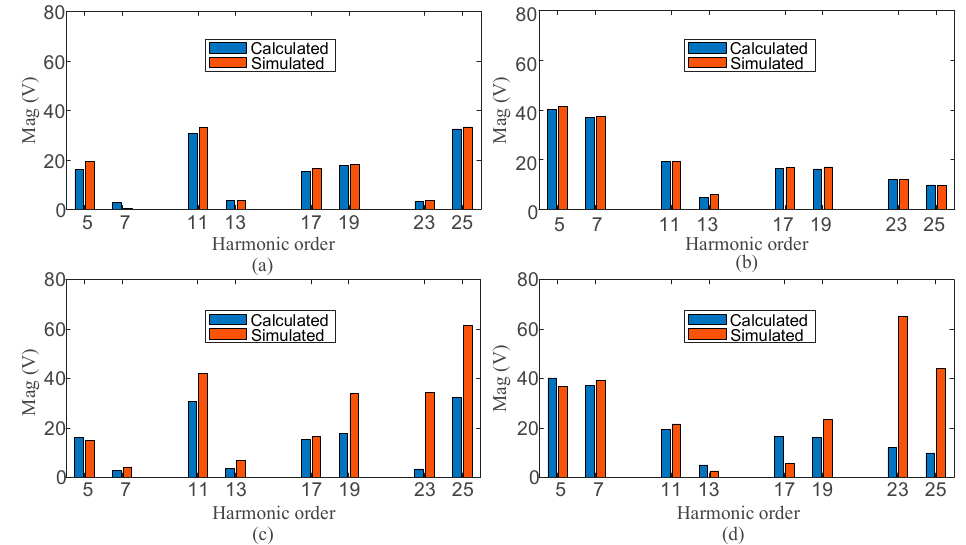
Figure 19. Quasi-unit power factor, open loop ( a ), non-quasi-unit power factor, open loop ( b ), quasi-unit power factor, closed loop ( c ), non-quasi-unit power factor, closed loop ( d ).